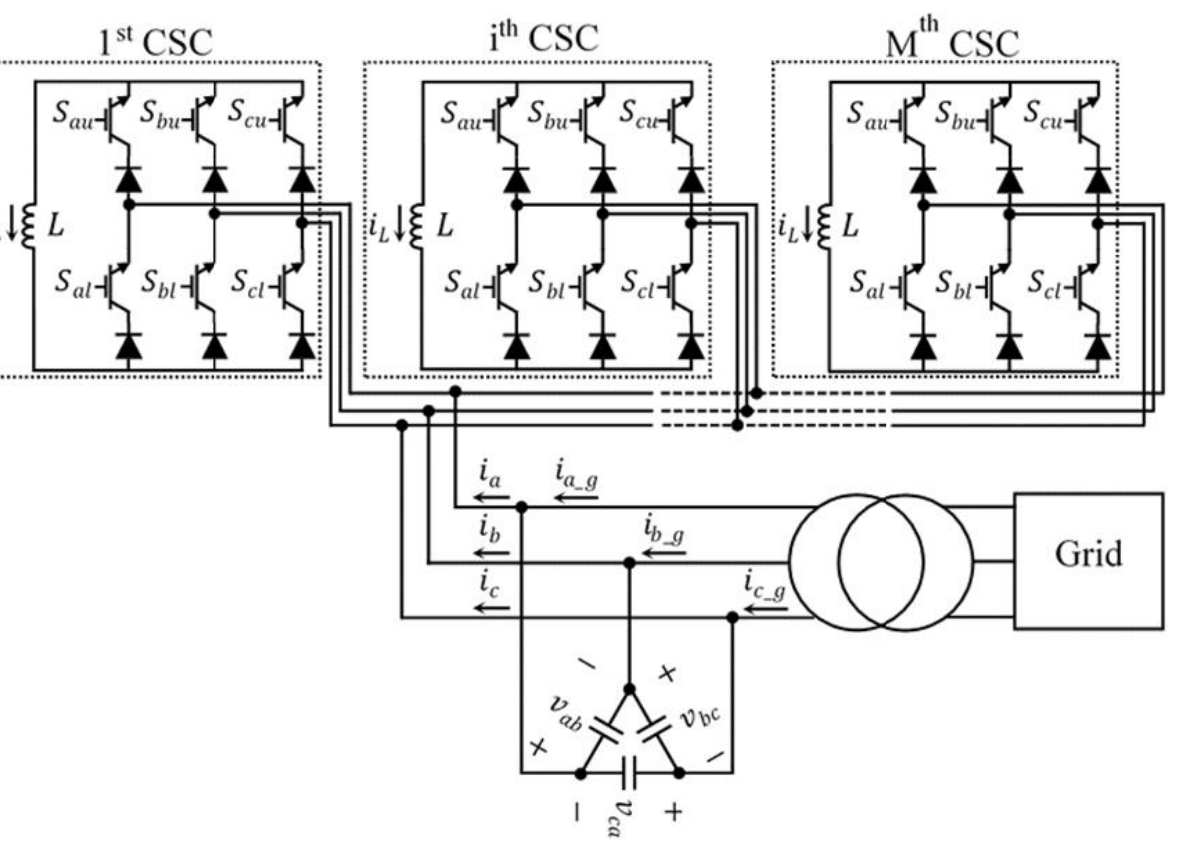
Figure 17. Parallel connection of CSC STATCOM for grid-connected utility for further flexibility and ancillary services, with multilevel based